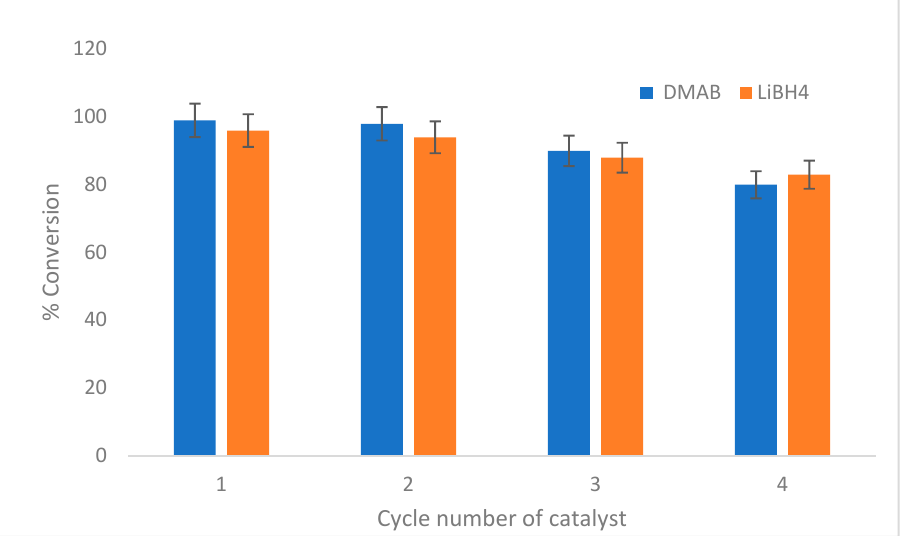
Figure 10. The reusability of nickel catalysts for DMAB and LiBH 4 hydrolysis for four cycles.